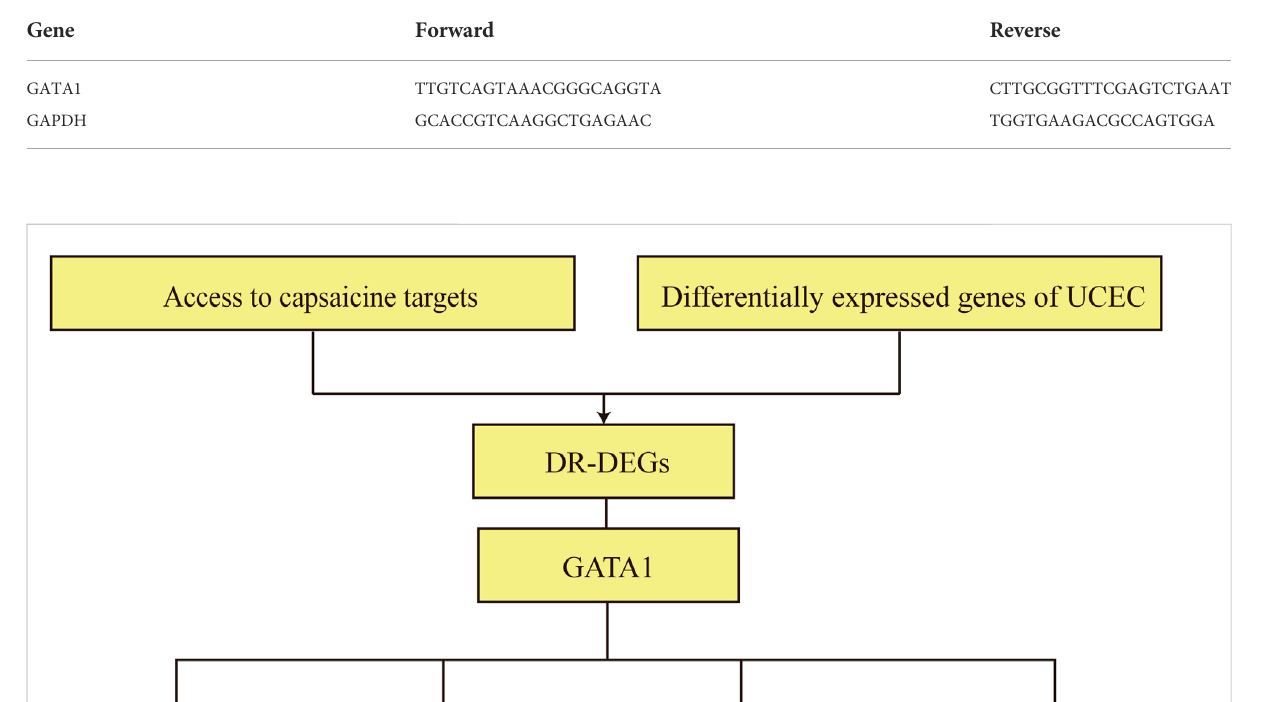
TABLE 1 The primer sequences for real-time PCR.